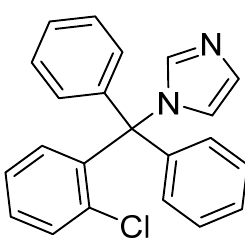
Figure 1. Structure of clotrimazole which is represented by L in the discussion.